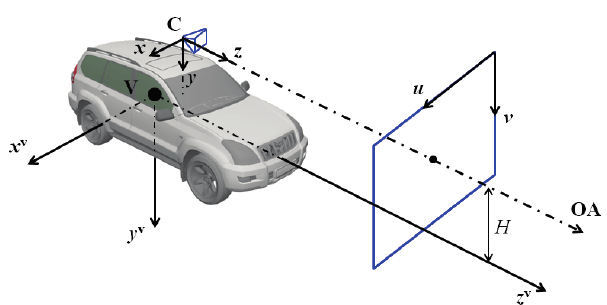
Figure 2. Coordinate system